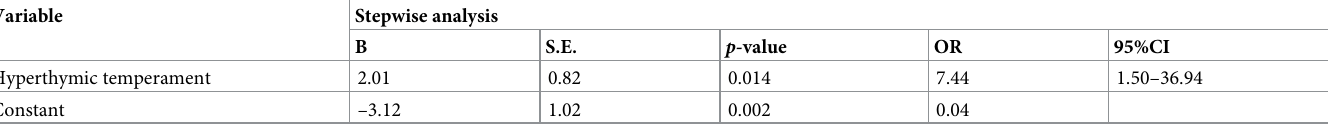
Table 4. Stepwise multivariate logistic regression analysis of the diagnosis of BD-II and